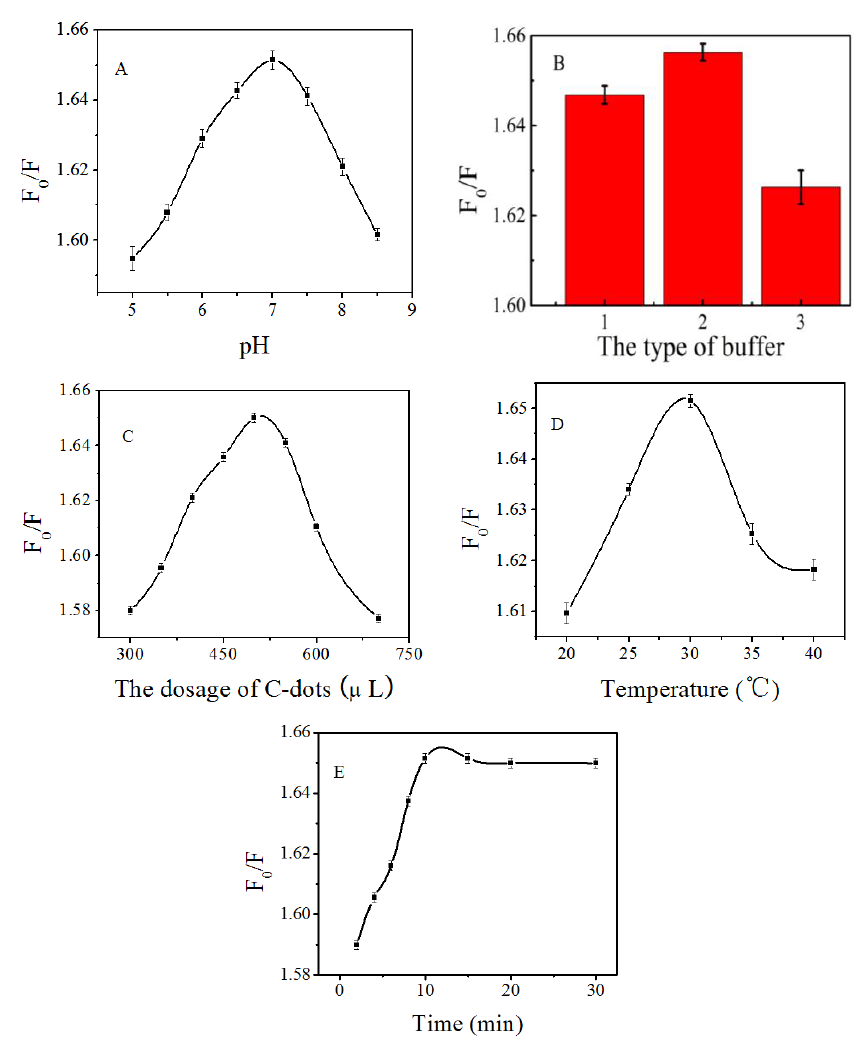
Figure 8. Effect of ( A ) pH; ( B ) the type of buffer (1. potassium phosphate, 2. sodium phosphate and 3. citrate solution); ( C ) the dosage of FCNs; ( D ) reaction temperature and ( E ) reaction time on the fluorescence intensity of the FCNs-MNZ system. Conditions: PBS, 0.2 M; MNZ, 125.00 μM.